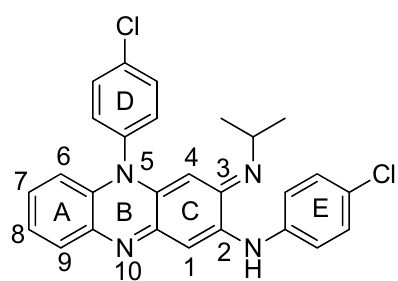
Figure 1. Structure of